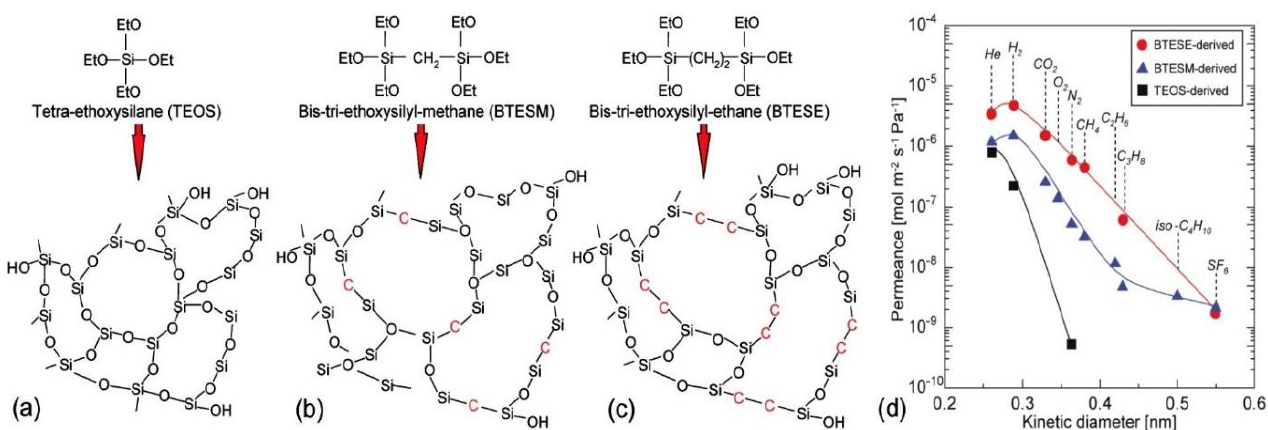
Figure 3. Schematic diagrams of amorphous silica networks derived by ( a ) TEOS, ( b ) BTESM, and ( c ) BTESE. The presence of (Si-CH 2 -Si) or Si-(CH 2 ) 2 -Si) moieties bridging alkoxysilanes in BTESM or BTESE increases the pore size and facilitates gas permeation as shown in ( d ). Adapted from [89] with permission.